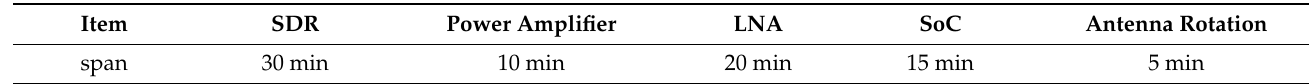
Table 4. Warm-up span.